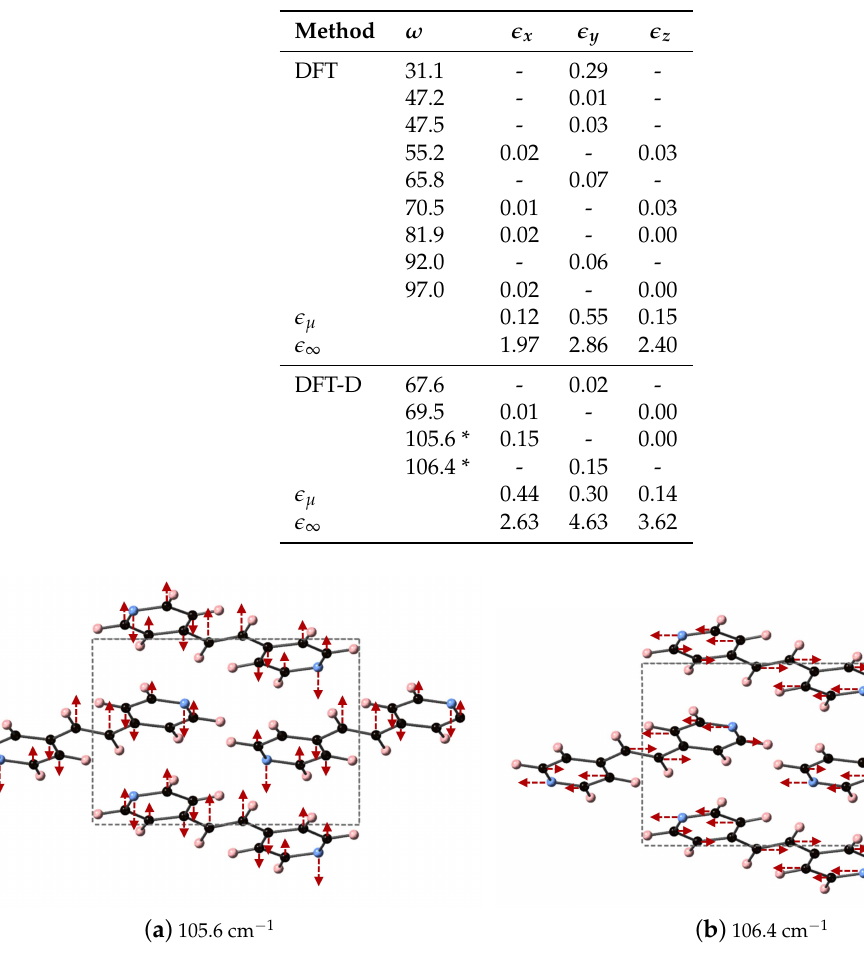
Figure 3. Depicted here are the DFT-D computed IR active vibrational modes of BPE that occur at ( a ) 105.6 cm − 1 (along the x -direction) and ( b ) 106.4 cm − 1 (along the y -direction. Color scheme is the same as before, but red arrows indicate relative atomic displacements. The displacements of H atoms are not shown for